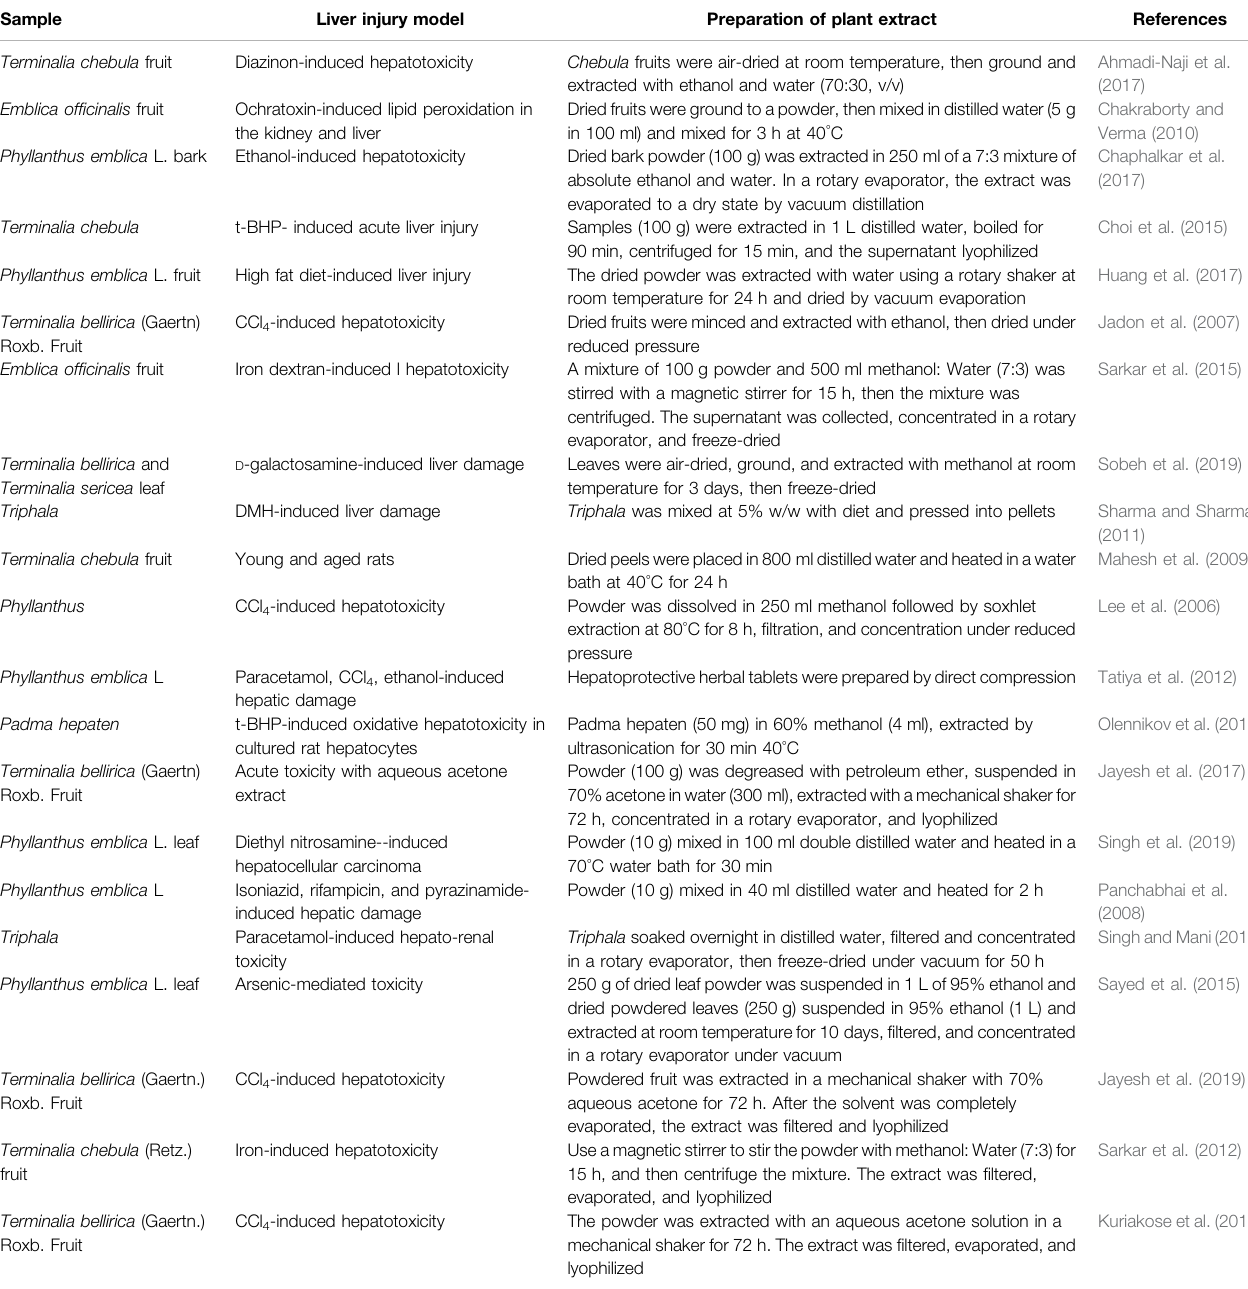
TABLE 1 | Preparation methods for Triphala and related botanical